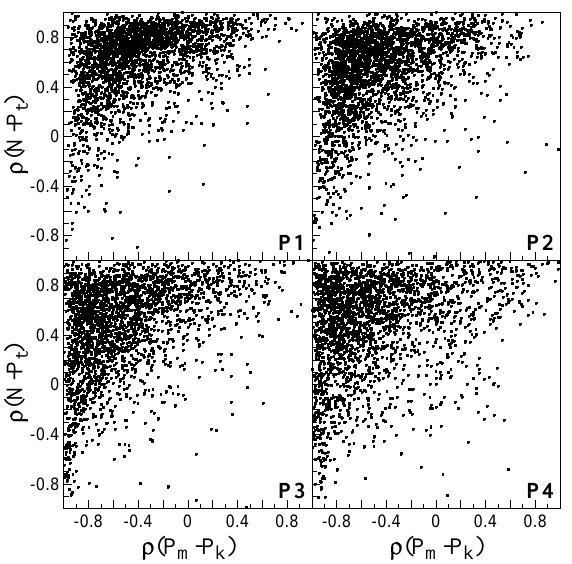
Fig. 6. Scatter plots of ρ(B − N) vs. ρ(B − T ) for polar wind samples P1 to P4.